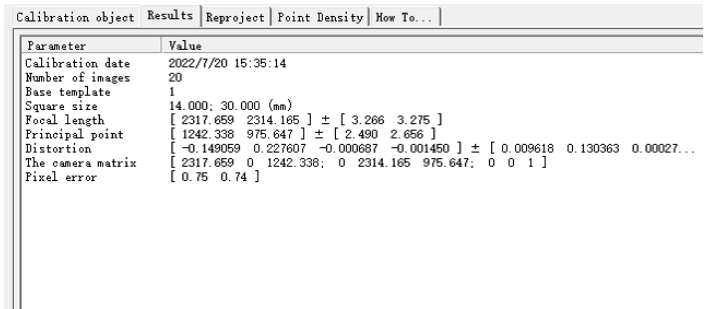
Figure 11. Camera calibration result diagram.